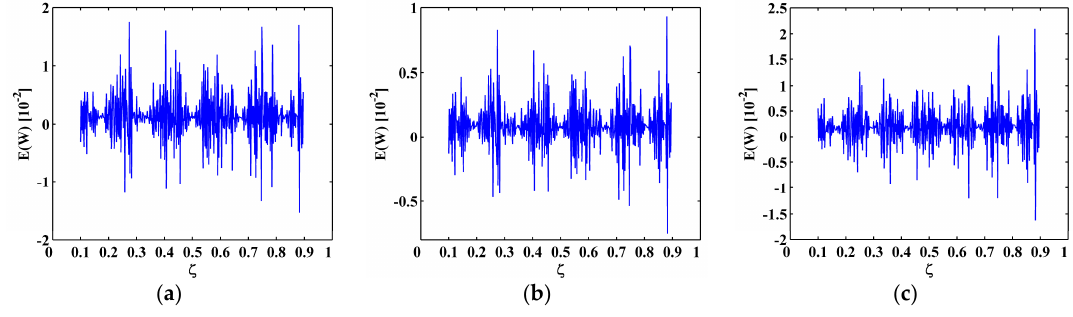
Figure 5. M-TKE for the ( a ) sixth; ( b ) seventh; and ( c ) eighth mode shapes with 60 dB SNR.